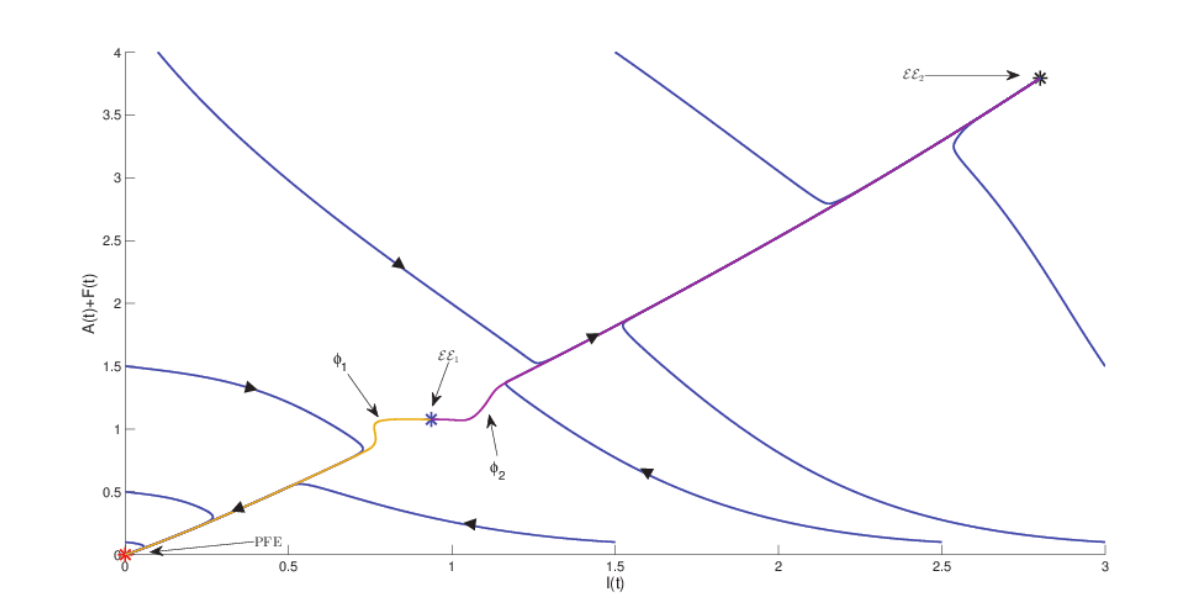
Fig. 3. If solutions of model (1) are initiated ‘close’ to the PFE convergence to this equilibrium occurs. Solutions that are initiated from the ‘smaller’ endemic equilibrium converge to either the PFE or the ‘larger’ equilibrium, dependent on the initial density of the susceptible